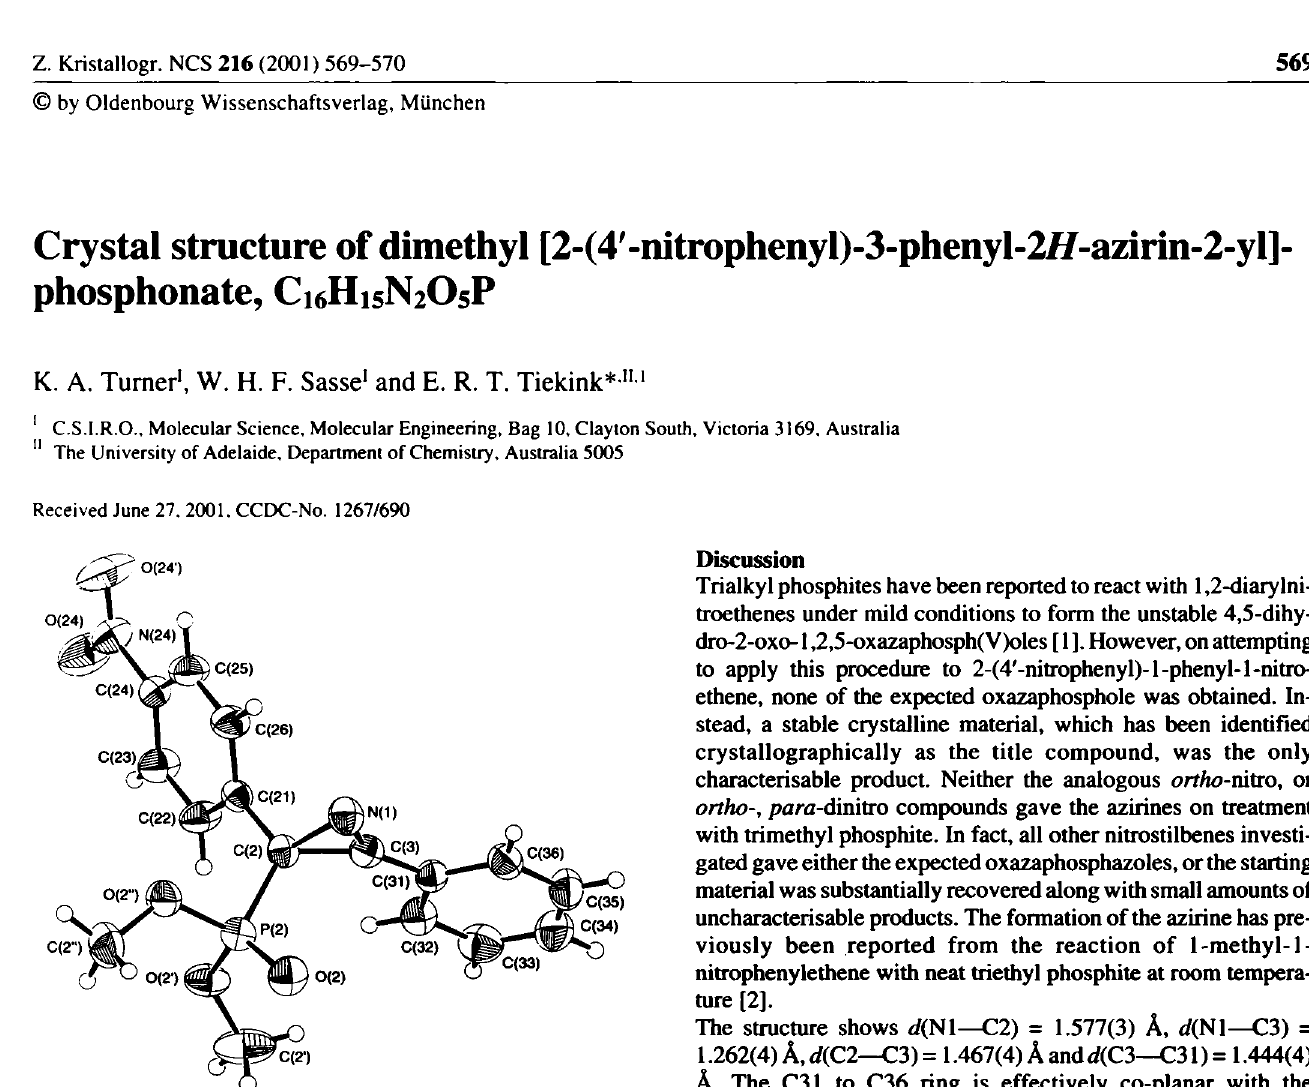
Table 1. Data collection and